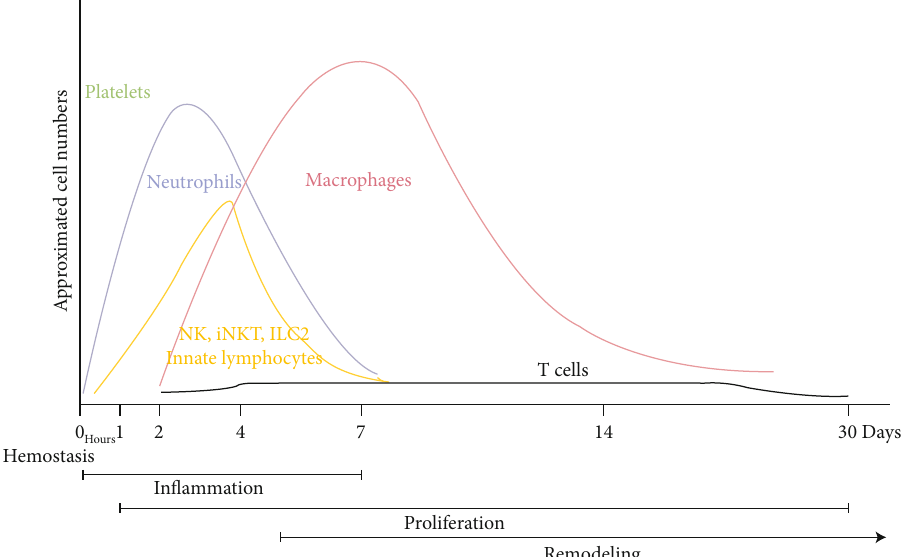
Figure 1: Wound healing process. Timeline of immune cell migration in relation with the phases of wound healing (adapted from